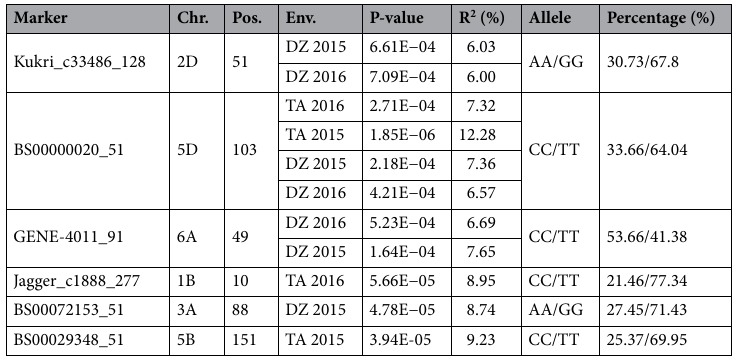
Table 4. SNP markers significantly associated with the brightness index (L* value) of flour colour in two locations in 2 years (P < 10 –4 ). Chr. chromosome, Pos. position, Env. environment.